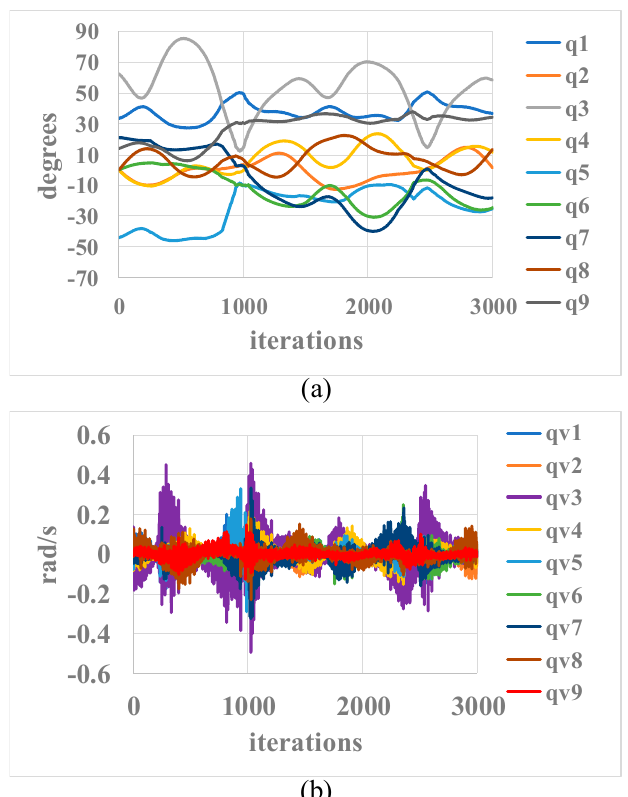
Figure 17. Joint angles and joint velocity of the improved PHUVS with the KF-SVSF method in the tracking experiment of a double leaf rose path. ( a ) Joint angles. ( b ) Joint velocities.